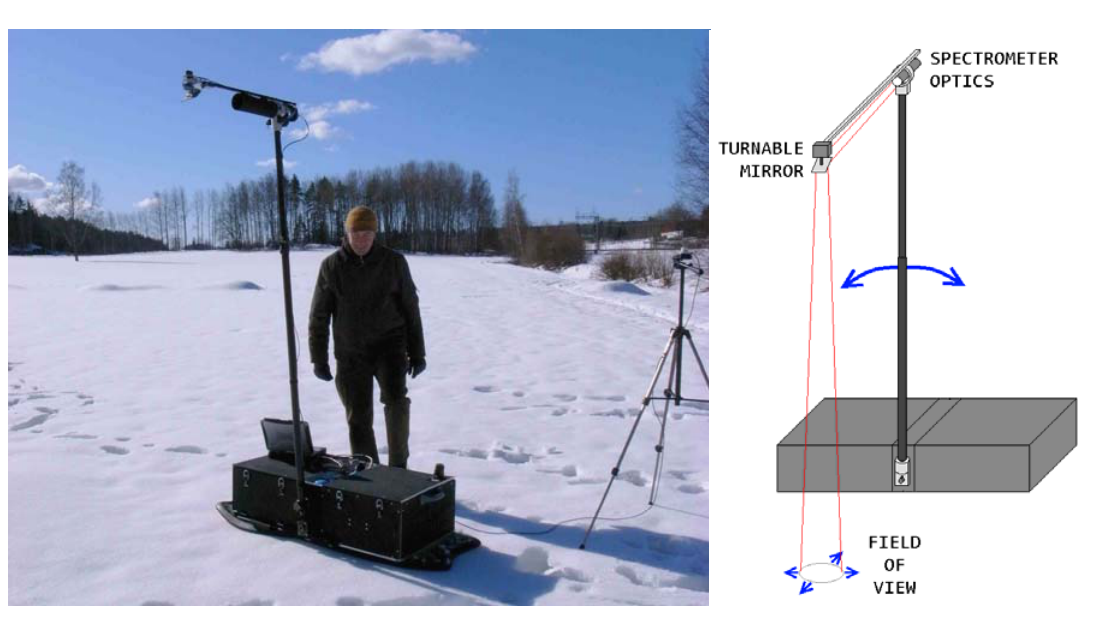
Figure 2. (Left) FIGIFIGO measuring snow at Kirkkonummi, Finland. (Right) Diagram of FIGIFIGO with directions of automated movement (blue arrows). The view zenith angle changes as the arm turns from side to side. The position of the footprint is stabilized with small mirror adjustments. When needed, two laser pointers (red lines) highlight the footprint